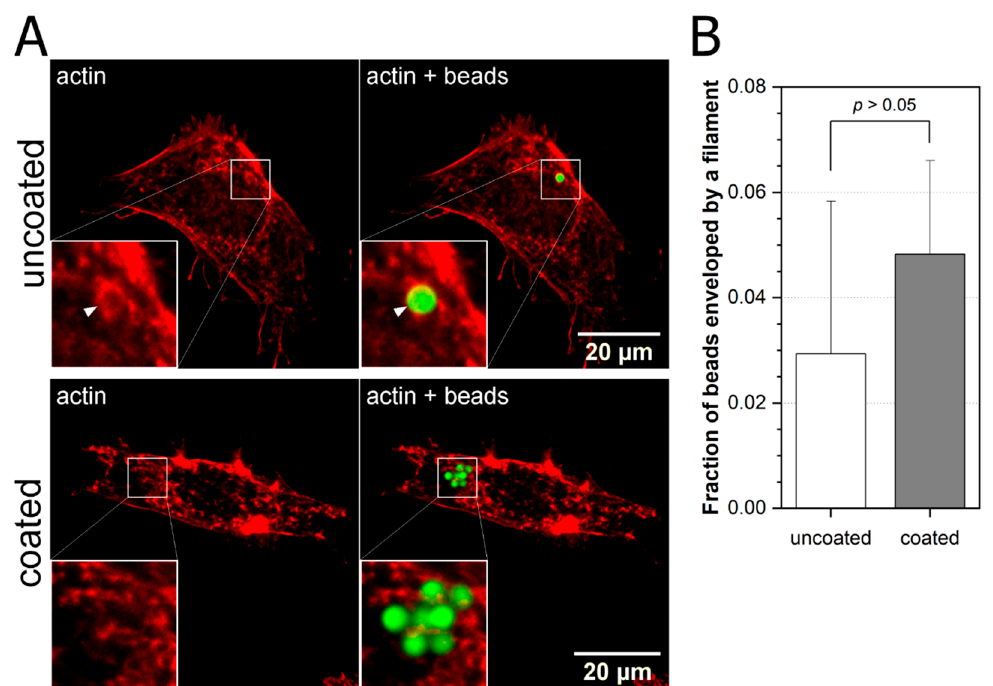
Figure 2. Lack of beads envelopment by actin filaments after treatment with cytochalasin D. ( A ) MEF cells were plated on glass-bottom dishes and cultured overnight then incubated with 2 µm latex beads (coated with fibronectin and uncoated) together with 20 µM cytochalasin D for 1 h and stained for actin. 3D images of cells were taken and analyzed. Representative images (as sum of stacks) are shown. ( B ) Beads enveloped by actin were counted and presented as fractions of all beads interacting with cells. Data are presented as a fraction ± SEM (uncoated, n = 34; coated, n = 145). Z-test was performed. Data are representative of at least two independent experiments.